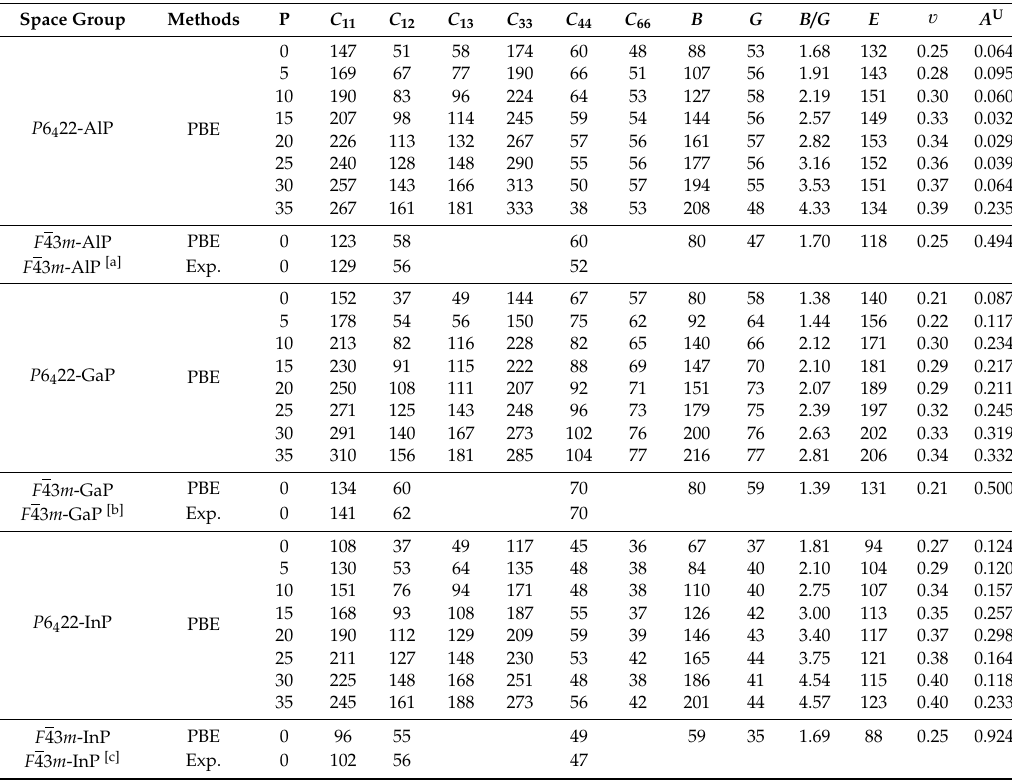
Table 2. The calculated elastic constants ( C 11 , C 12 , C 13 , C 33 , C 44 , C 66 ), bulk moduli B , shear moduli G , Young’s modulus E (GPa), Poisson’s ratios v and universal anisotropic index A U for P 6 4 22- X P ( X = Al, Ga, or In) when pressure P (GPa) increases from 0 to 35 GPa via the method of GGA-PBE. Space